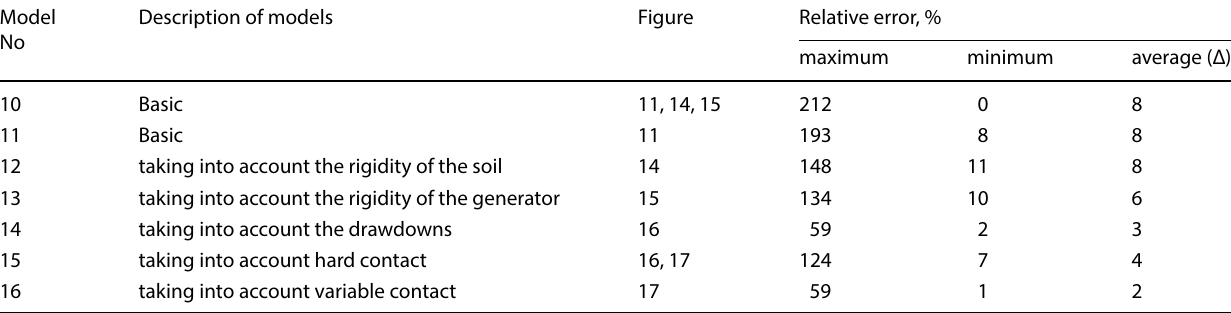
Table 2 Numerical assessment of the adequacy of models Model Description of models Figure Relative error, No